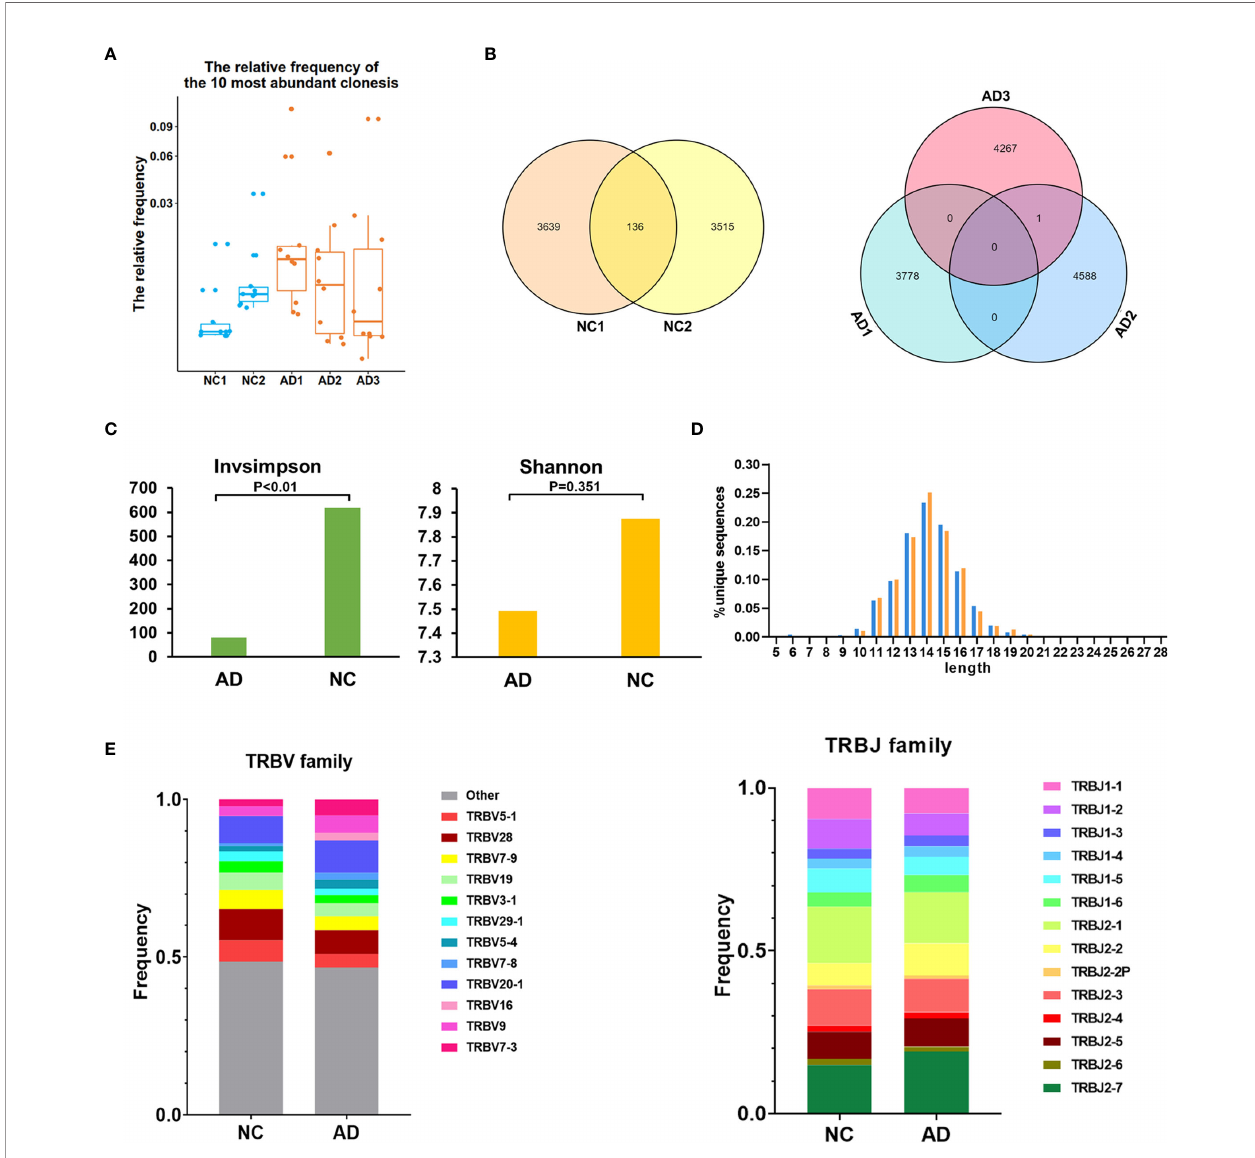
FIGURE 4 | T cell receptor(TCR) repertoire analysis. (A) Box plot showing the top10 high-frequency T cell clonotypes for each sample in this study. (B) Venn diagramsof the publicT cellclonotypes within the Alzheimer ’ s disease (AD)group and normal controls (NC). (C) Averages of the InvSimpsonindex and Shannon – Weiner index of each sampleare usedto compare the TCR diversity of the AD group and NC. (D) Distribution of the CDR3 aminoacid length of the TCR in the AD group and NC. (E) V and J genes usage frequency stacked histogram showingthe distribution of common V and J genes of the TCR inthe ADgroupand NC